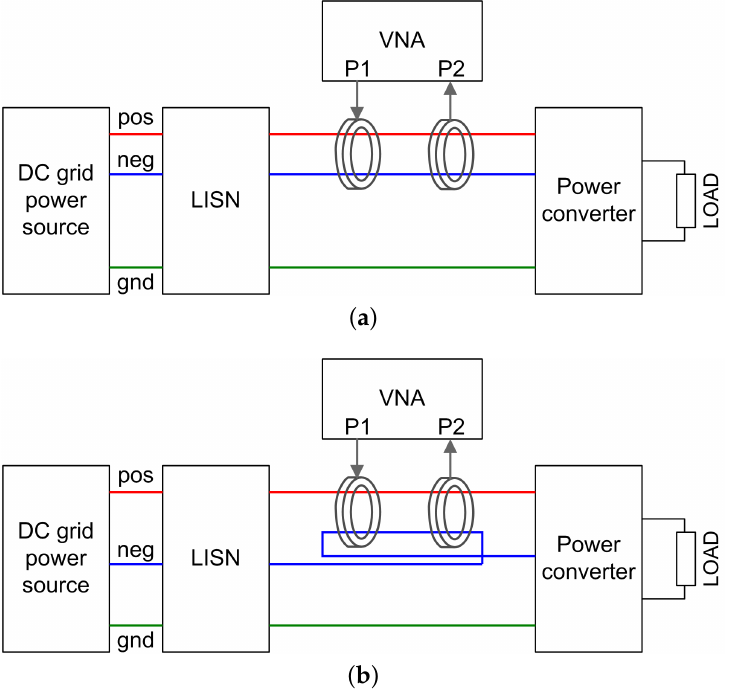
Figure 1. Setup for active measurement of WPT input impedance: ( a ) common mode, ( b ) differen- tial